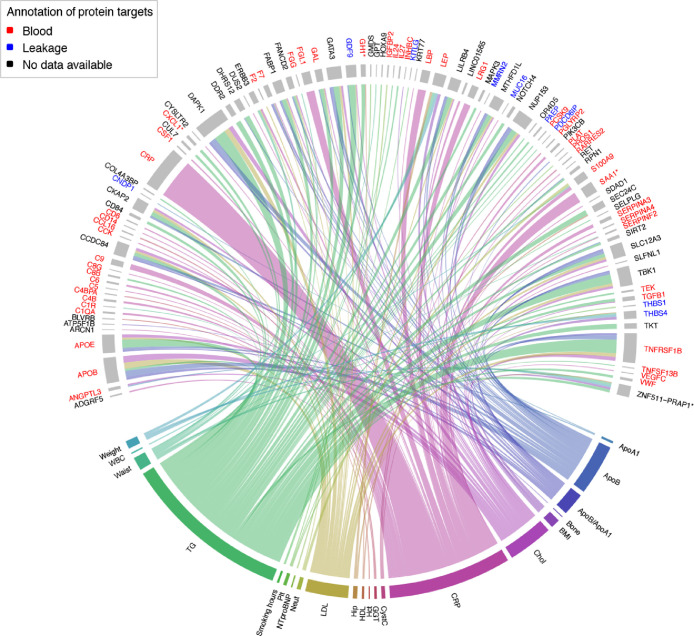
Association map of proteomics and clinical traits. Chord diagram of associations(FDR P < 0•001) between protein profiles and clinical traits obtained from linear mixed effect models. Line thickness is proportional to -log10(P-value) and coloured by clinical trait. Protein features that represent a family of several proteins are denoted with one gene name followed by “*”. Feature names are coloured red if predicted to be actively secreted into blood, or blue if they appear in blood due to cell leakage [9,40] (For interpretation of the references to color in this figure legend, the reader is referred to the web version of this article.).